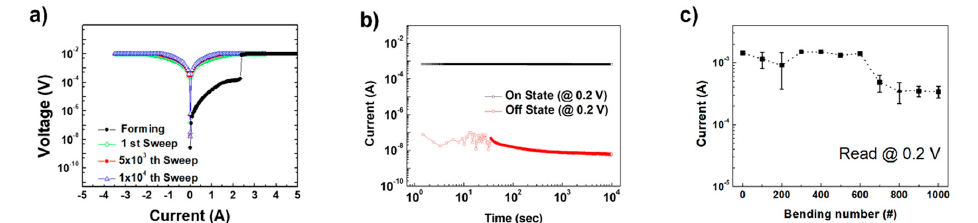
Figure 8. Memory characteristics of the Pt/GO/PEDOT:PSS/GCA 1:1 –AgNW/PET structure ReRAM. (a ) I–V curve, ( b ) retention performance data, and ( c ) bending test results.